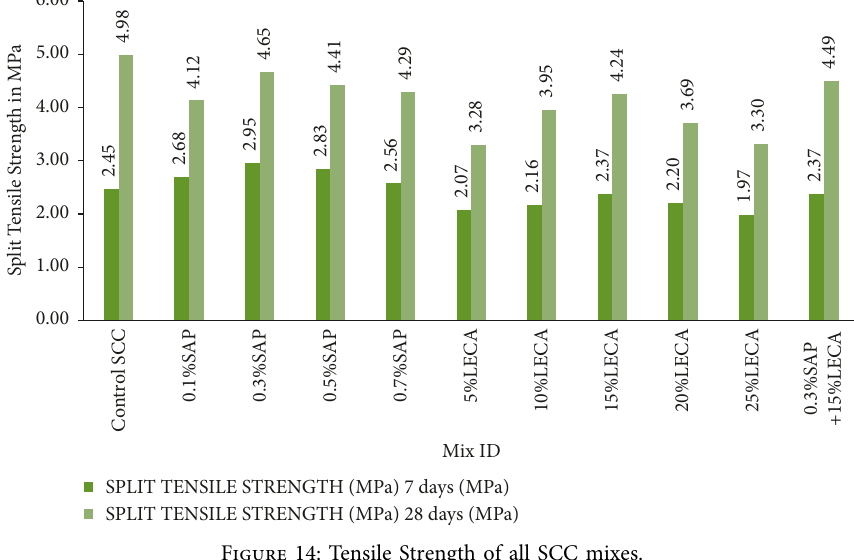
Figure 14: Tensile Strength of all SCC mixes.